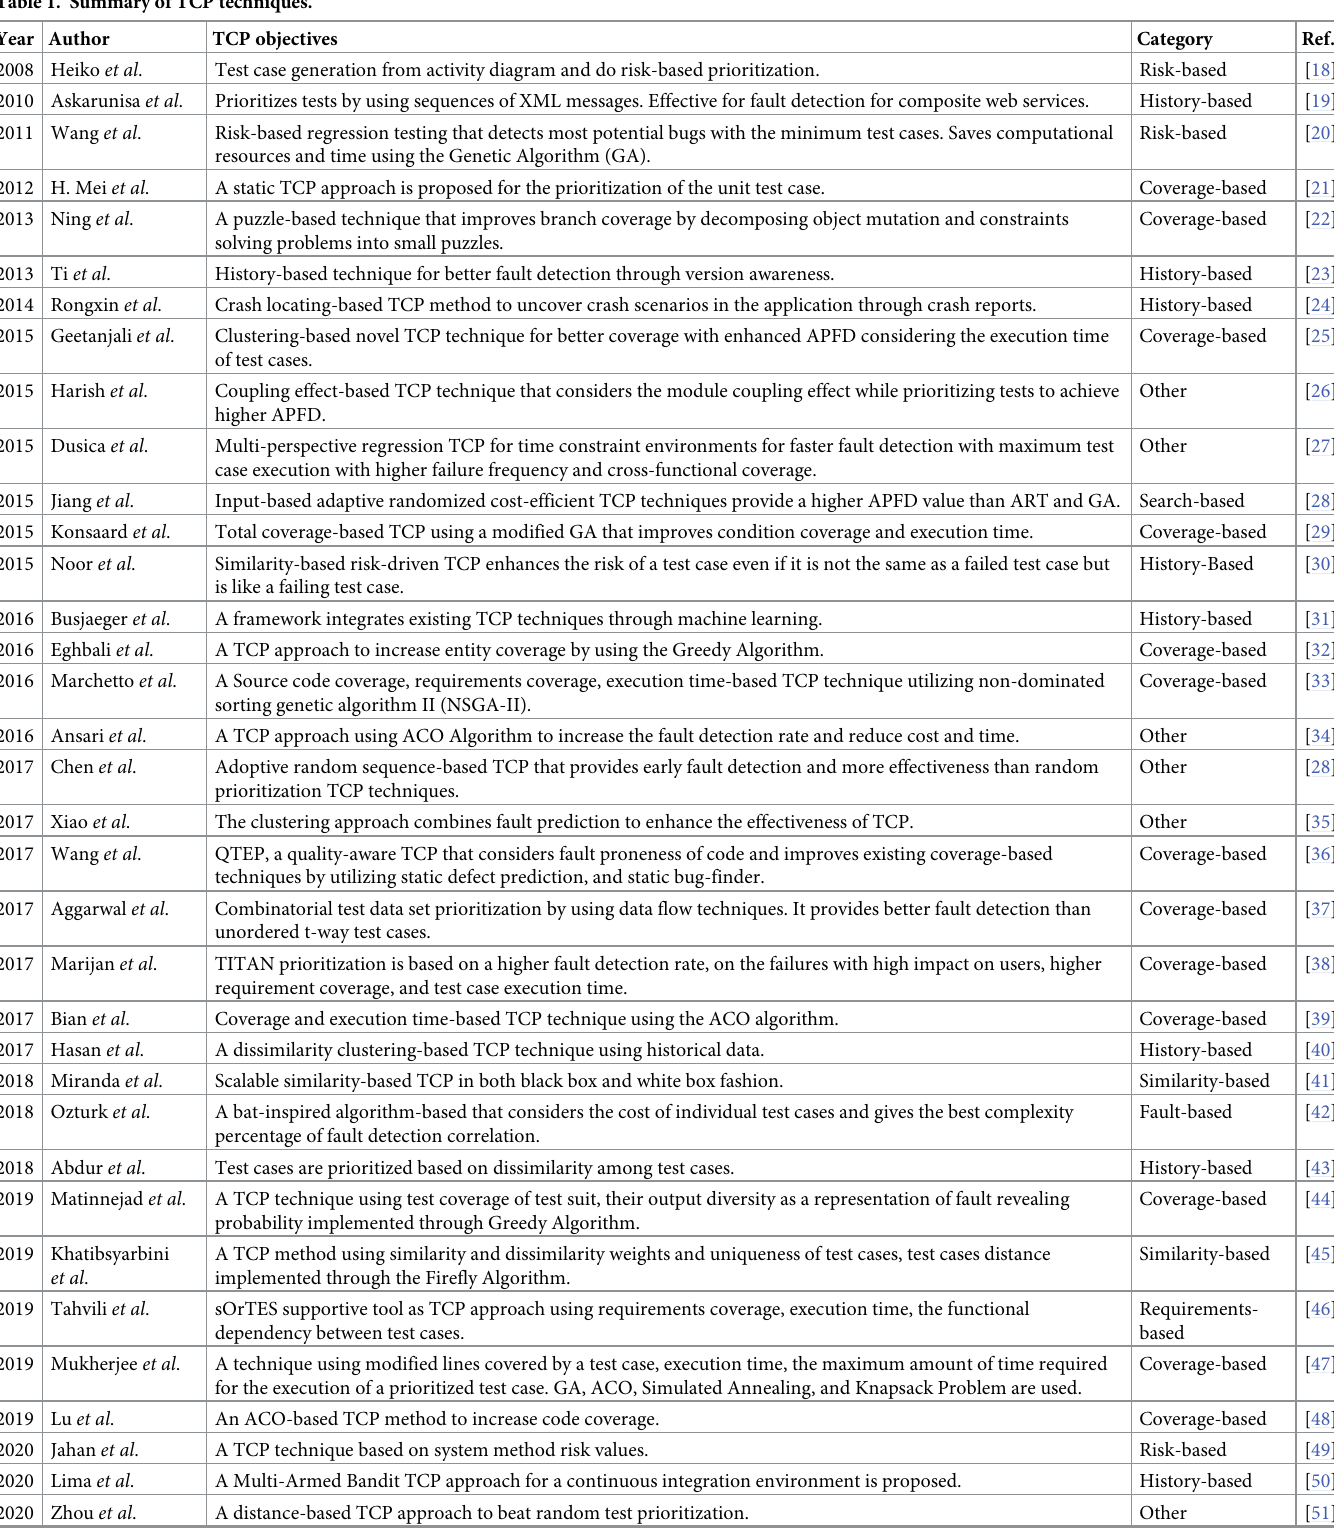
Table 1. Summary of TCP